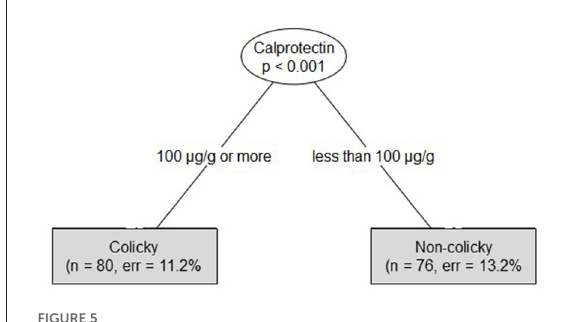
FIGURE5 Conditional inference tree using fecal calprotectin level data to determine the colicky status of an infant.